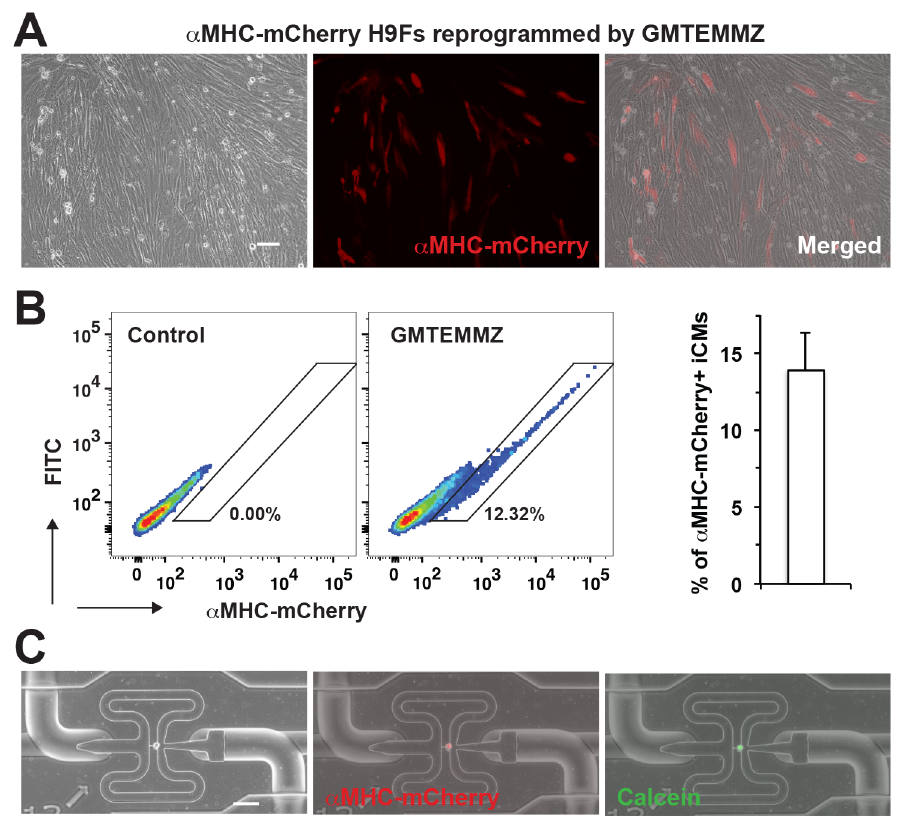
Fig 1. Harvesting individual reprogrammed α MHC-mCherry + H9F iCMs for single-cell qPCR. A) Many α MHC-mCherry + iCMs were observedin reprogrammed H9Fs 4 weeks after retroviral infectionof GMTEMMZ. B) α MHC-mCherry + iCMs were quantified and purifiedby FACS sorter. C) Representative single α MHC-mCherry + iCM captured by C1 Single-Cell Auto Prep System. A positive staining of calceinindicates cell viability. Scale bars, 20 μ